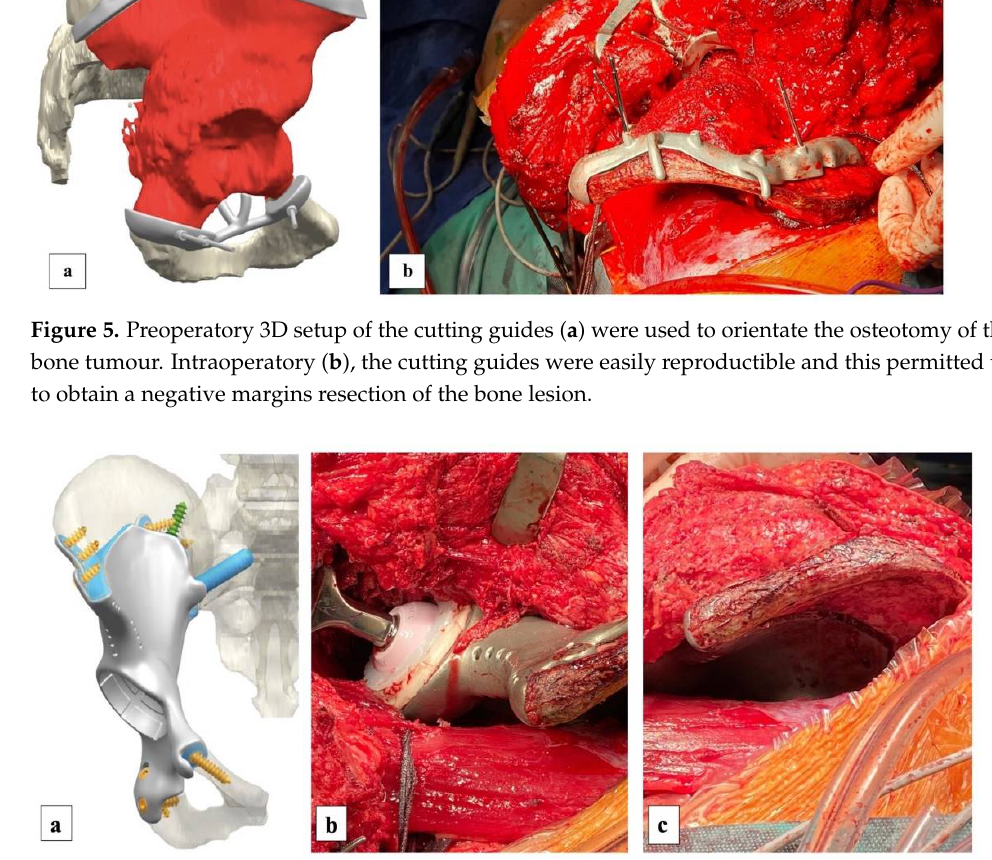
Figure 7. Image of the resection sample ( a ) that fitted in length and width with the preoperatory layout of the implant. This ( b ) may be used to assure the surgeon during the positioning of the cutting guides in case of difficulties. The resection sample was also radiographed (lateral view) ( c ). The bone defect was reconstructed with a custom-made 3D-printed pelvic prosthesis that was fixed with 6.5 mm cancellous screws in the obturator quadratus and in the rem- nant iliac bone (Figure 6). In addition, an 8.0 mm cancellous screw was added into the posterior part of the remnant iliac bone. Ilio-sacral fusion was performed using a 10 mm uncemented stem. In the end, the medius gluteus and the gluteus flap were reinserted on the iliac crest; the